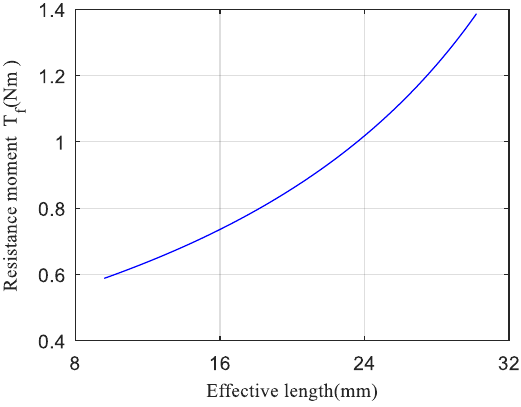
Figure 12. The relationship between resistance moment and effective length.